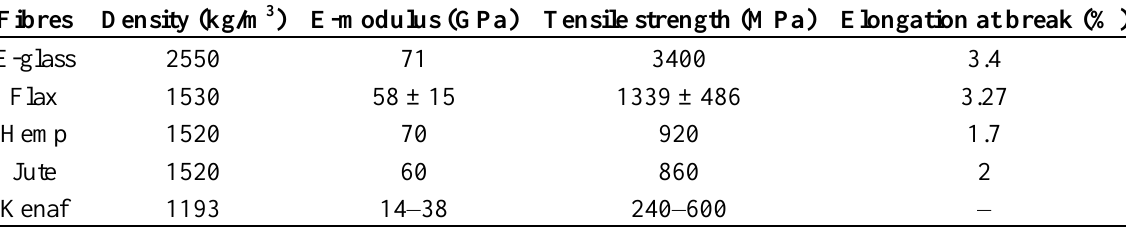
Table 2. Typical properties of some bast fibres compared to E-glass